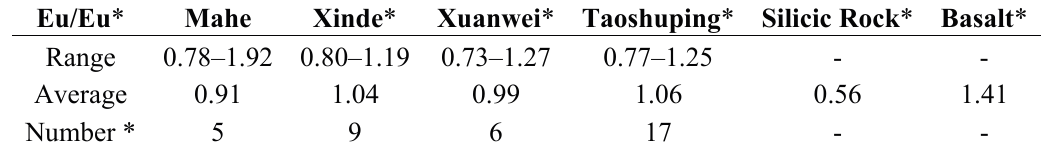
Table 5. Eu/Eu* value, normalized to Upper Continental Crust (UCC)[43], in Late Permian coals from eastern Yunnan, and the Emeishan silicic rock and basalt. Eu/Eu * Mahe Xinde * Xuanwei * Taoshuping * Silicic Rock * Basalt * Range